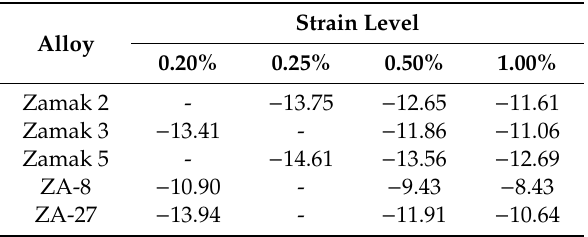
Table 4. Values of C (cid:48) for several alloys and levels of creep strain for use in Equation (3) (based on data from [40,73]). Strain Level Alloy 0.20% 0.25% 0.50% 1.00% Zamak 2 - − 13.75 − 12.65 − 11.61 Zamak 3 − 13.41 - − 11.86 − 11.06 Zamak 5 - − 14.61 − 13.56 − 12.69 ZA-8 − 10.90 − 8.43 ZA-27 − 13.94 − 11.91 −